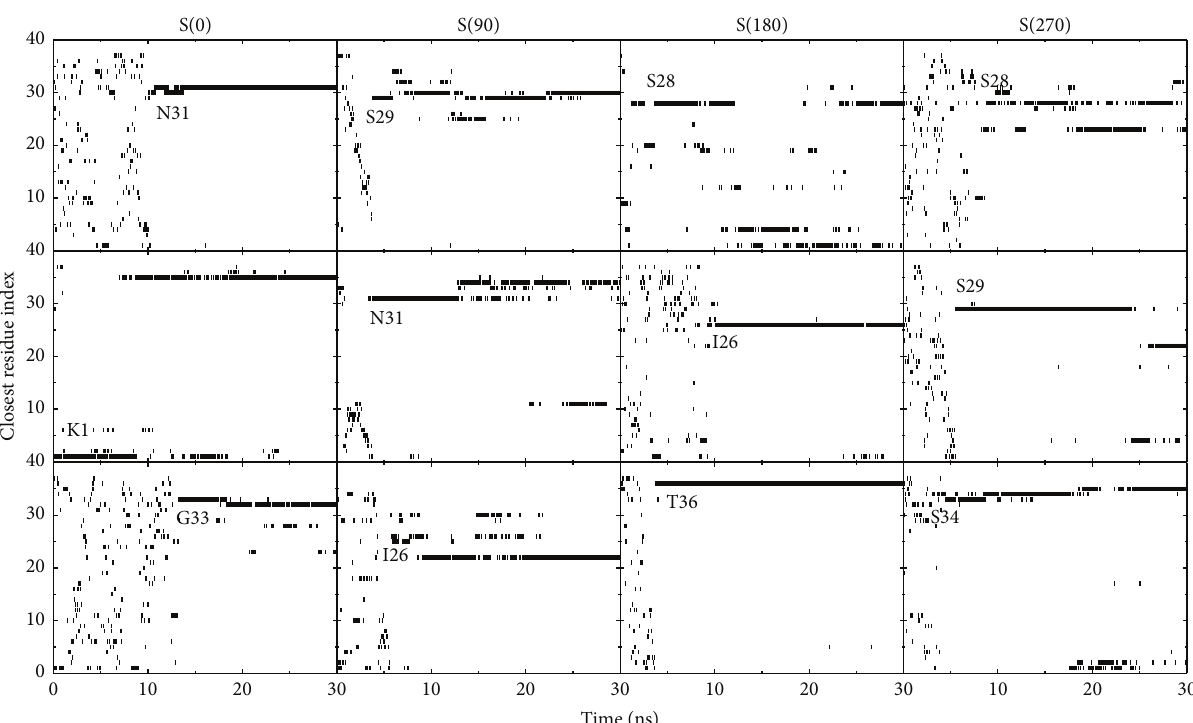
Figure 2: Index of residues closest to the POPC membrane surface as a function of time. A residue is considered to be the one closest to the bilayer surface if the 𝑧 -position of its centroid is the smallest relative to the average 𝑧 -position of the phosphorus atoms. In water solution, the closest residue index varies with time; once the peptide adsorbs to the membrane surface, the index of the residue closest to the POPC bilayer rarely